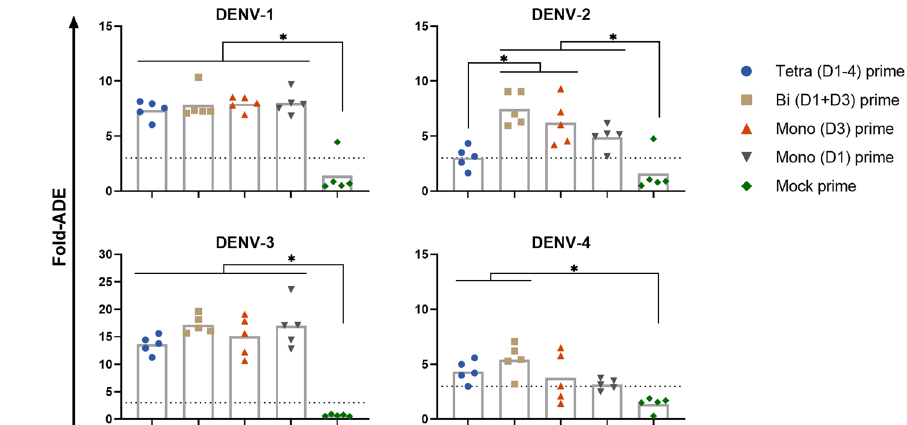
Fig. 2 In vitro enhancement of DENV infection by sera from day 28 post-PIV vaccination. Each of the four DENV types was mixed with a 1/8 dilution of sera from each group, and the infectivity of each was measured relative to the virus alone (fold-ADE). Bar heights are the means for each group. Data were analyzed using a one-way ANOVA model with Tukey ’ s multiple comparisons test. * p <